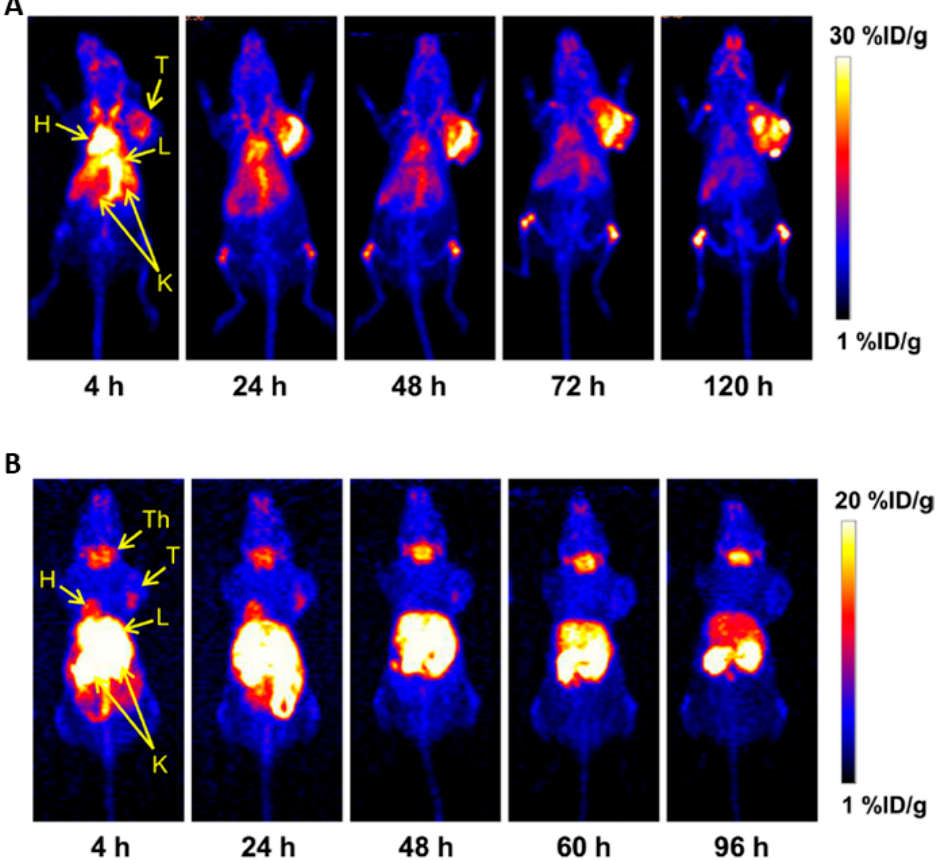
Figure 4. Serial maximum intensity projection (MIP) PET images of mice injected with A) [ 52 Mn]Mn- DOTA-TRC105 and B) 52 MnCl 2 . Note: H, Heart; L, Liver; K, Kidneys; T, Tumor; Th, Thyroid. Adapted